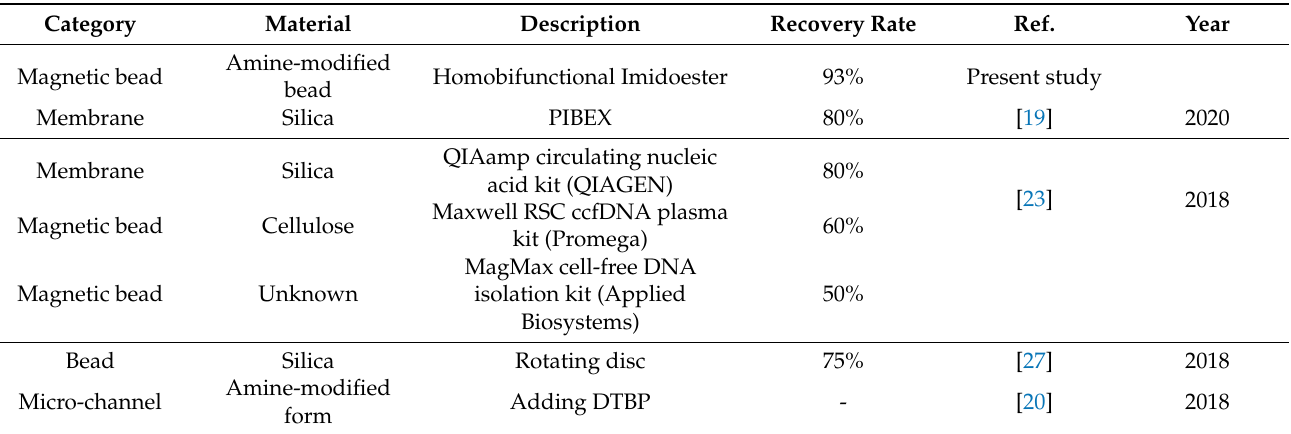
Table 1. Summary of cfDNA extraction.